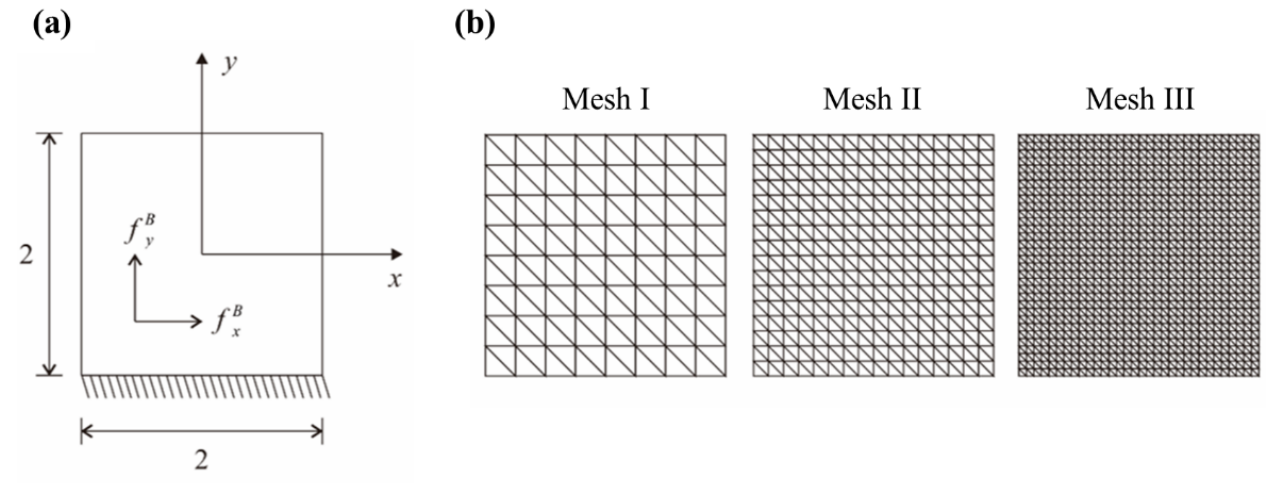
Figure 9. Ad hoc problem: ( a ) Problem description. ( b ) Triangular meshes (Mesh I, II, and III) used.